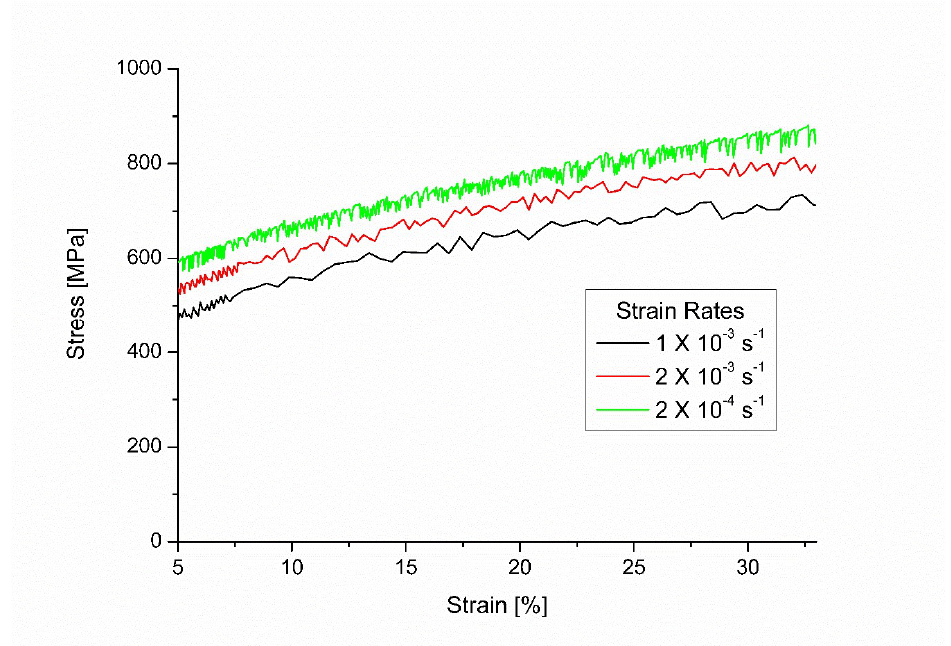
Figure 5. Details of the stress-strain curves obtained in the Inconel 625 tensile tests at 600 °C varying the strain rate. For the curves with strain rates of 2 × 10 −3 and 2 × 10 −4 , 50 and 100 MPa were subtracted respectively, generating a vertical deviation of the curves for a clear comparison of the PLC effect behavior.